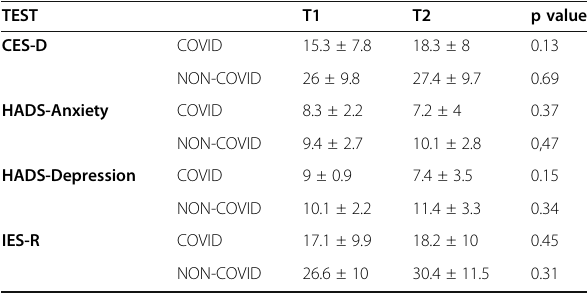
Table 3 (abstract A125). Subgroup analysis regarding the tests for Depression, Anxiety and PTSD between videocalls. Caregivers are separated according to the admission diagnosis (patients admitted to ICU with COVID or non-COVID